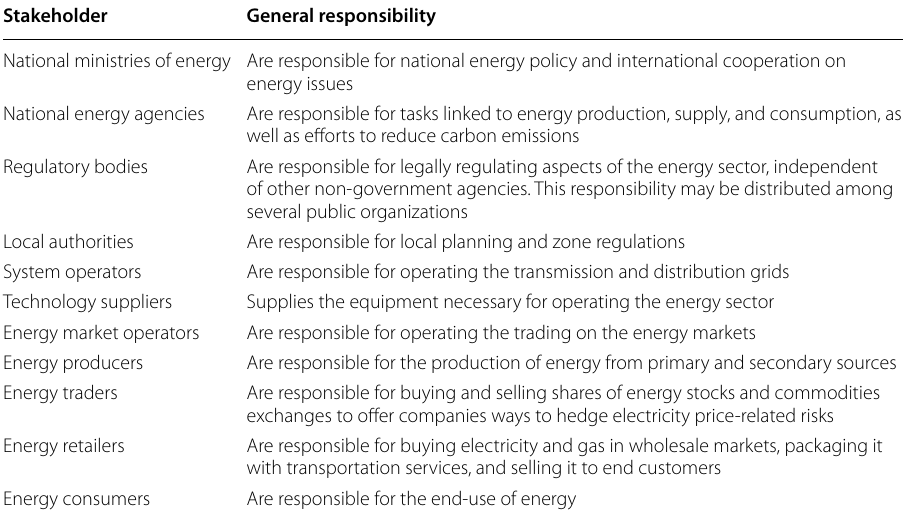
Table 1 General responsibilities of stakeholders in the energy ecosystem Stakeholder General